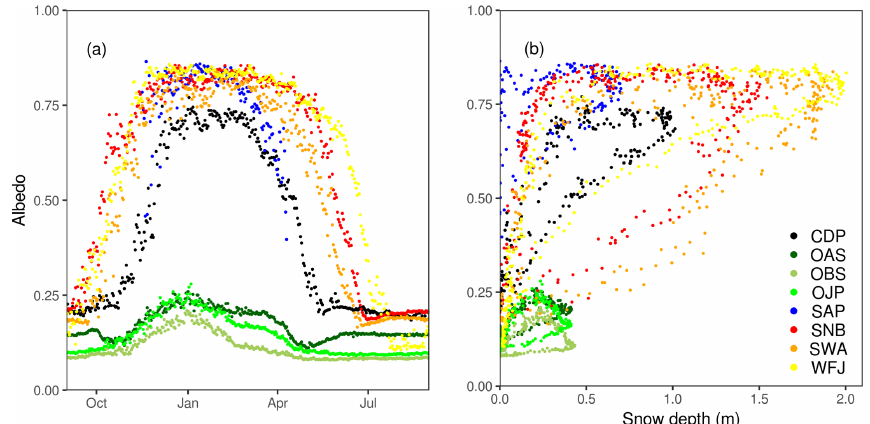
Figure 7. Daily climatological averages of albedo over time (a) and as a function of snow depth (b) at all sites except RME and SOD.